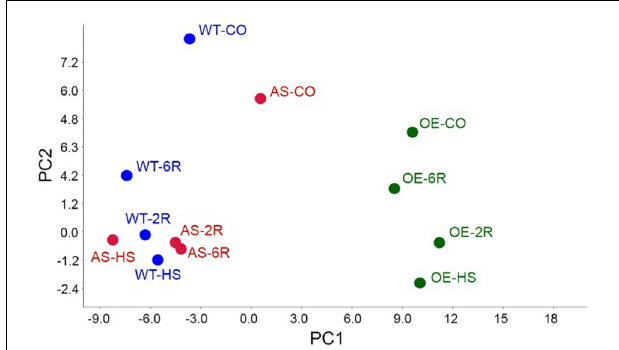
FIGURE 2 | Principal component analysis (PCA). PCA of samples integrating both primary and secondary metabolites with the components 1 (PC1, 67%) and 2 (PC2, 12%) in WT, B1OE and B1AS lines in control (CO) and heat stressed (HS) leaves as well as after 2 (2R) or 6 h (6R) of